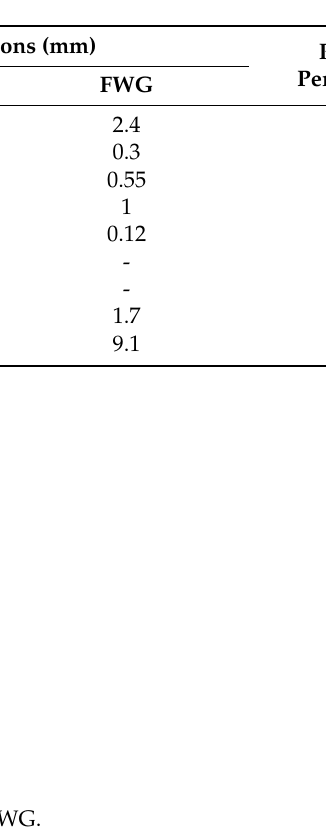
Figure 9. Normalized phase velocity of CV-FWG and conventional FWG.